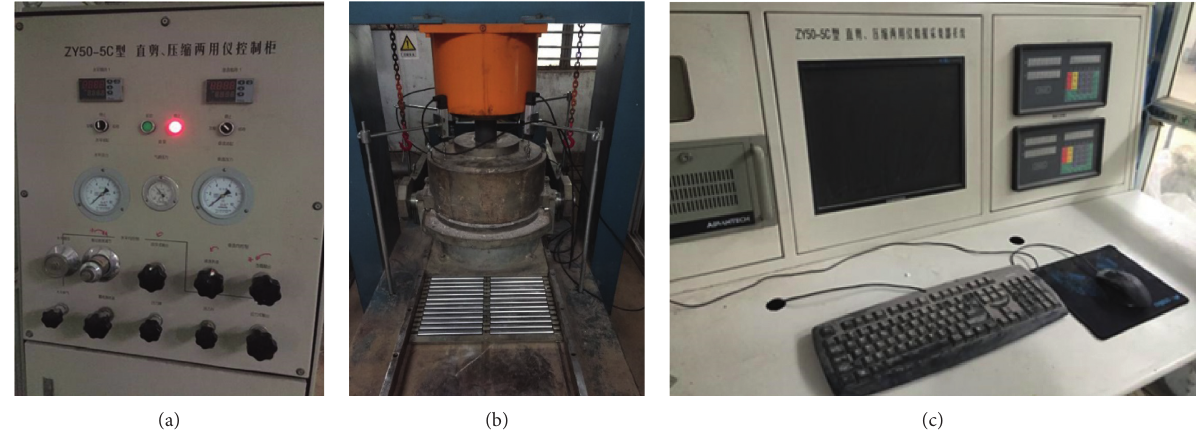
Figure 1: ZY50-5C. (a) Control system. (b) Host structure. (c) Acquisition system.